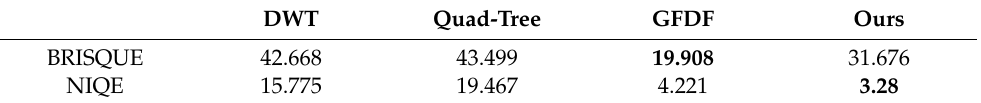
Table 5. Blind image quality evaluation results for third dataset of conjunctival goblet cell